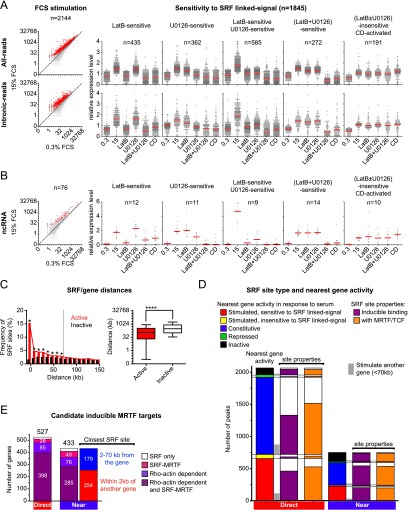
The majority of serum-inducible genes are MRTF-controlled. (A, left) Scatter plot display of total (top) and intronic (bottom) RNA-seq read counts before and after serum stimulation. Serum-stimulated genes (FDR = 0.2) are highlighted in red. (Right) Definition of serum-inducible genes sensitive to SRF-linked signal pathways (FDR = 0.08). (Red bars) Median. See Supplemental Table S2. (B) Signaling to ncRNA genes, as in A. See Supplemental Table S3. (C) SRF sites are overrepresented within 70 kb of transcriptionally active genes. (Left) Frequencies of SRF sites relative to active and inactive genes (per 10-kb bin relative to TSS or pA site). Zero indicates sites within 2 kb of the TSS or within a gene feature. (Asterisks) Significant at P < 0.05, multiple t-test with Holmes-Sidak correction. (Right) SRF-binding sites are significantly closer to active genes. (Asterisks) Significant at P < 0.0001, Mann-Whitney test. See Supplemental Table S4. (D) Relationship between SRF peak properties and activity of their closest associated gene. The left bars indicate peaks classified according to activity of the closest gene, gray bars at the side indicate the fraction of these peaks associated with regulatory events at genes up to 70-kb distant, the center bars represent classification of peaks by SRF-binding inducibility, and the right bars represent classification of peaks by cofactor association. (Direct) Sites within 2 kb of 5′ flanking sequences or within a gene feature; (near) sites within 70 kb of the TSS or pA site. See Supplemental Table S4. (E) Candidate MRTF serum-inducible genes (defined by MRTF binding, sensitivity to LatB or CD, or both) categorized by distance from the nearest SRF sites, as in D. Many inducible genes whose closest SRF site lies within 70 kb share that site with a second gene. See Supplemental Table S4A.